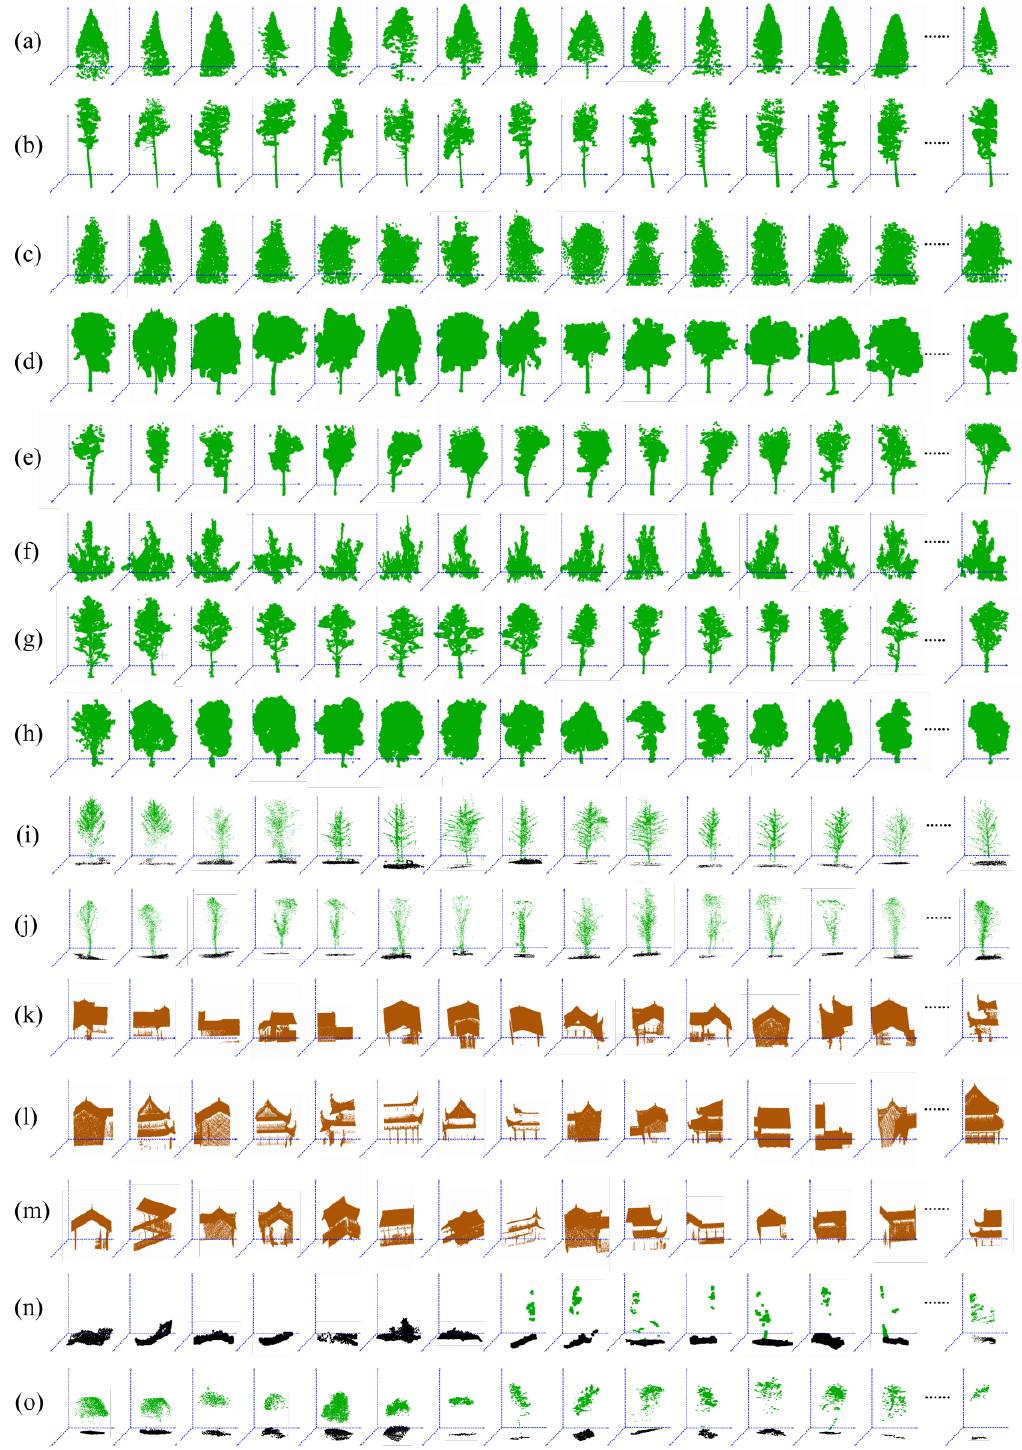
Figure 3. Illustration of the partial training sets of point clouds collected for the PointNet network. Lines 1 to 10 are extracted individual trees of corresponding scanned points regarding different tree species, namely ( a ) metasequoias, ( b ) Chinese firs, ( c ) cedars, ( d ) ginkgoes, ( e ) sapindus, ( f ) apple trees, ( g ) poplars, ( h ) camphors, ( i ) ceibas, and ( j ) locust trees, respectively. The last five lines ( k – o ) are parts of buildings including palaces, city walls, temples, and houses in different Chinese architectural styles and other objects including bare ground, understorey vegetation and a small portion of point clouds regarding a single tree (usually <20%) or intersection parts of adjacent trees.